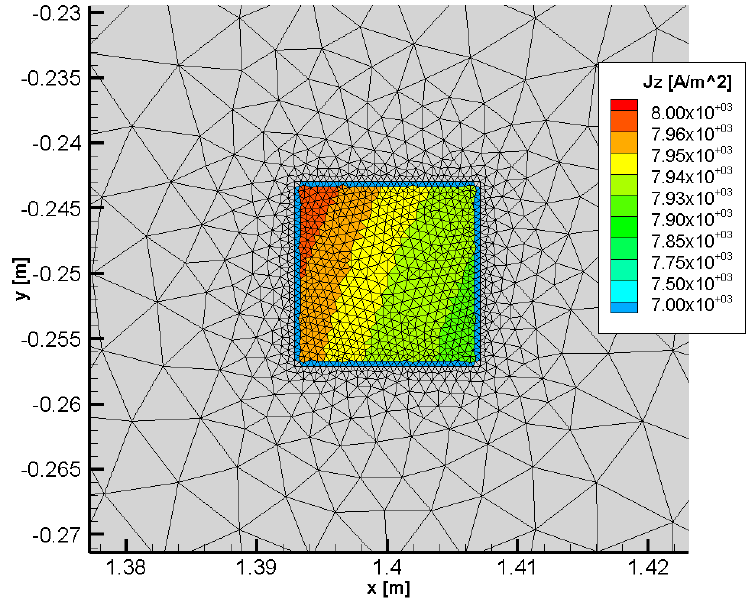
Figure 7. Current density magnitude distribution in a square mitigation